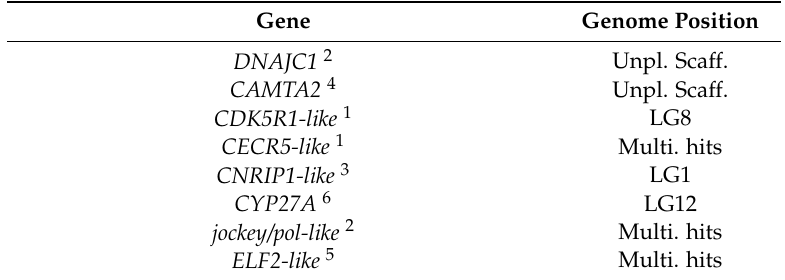
Table 1. Putative Y-linked genes and their positions in the Poecilia reticulata genome. Gene Genome Position DNAJC1 2 Unpl. Scaff. Unpl. Scaff. CAMTA2 4 Unpl. Scaff. CDK5R1-like 1 LG8 Multi. hits CECR5-like 1 Multi. hits CNRIP1-like 3 LG1 LG12 jockey/pol-like 2 Multi. hits Multi. hits ELF2-like 5 Multi. Multi. hits EPHB4-like 2 Unpl. Scaff. gastrula zinc finger protein XlCGF17.1-like 3 Multi. hits GSN 1,5 Unpl. Scaff.